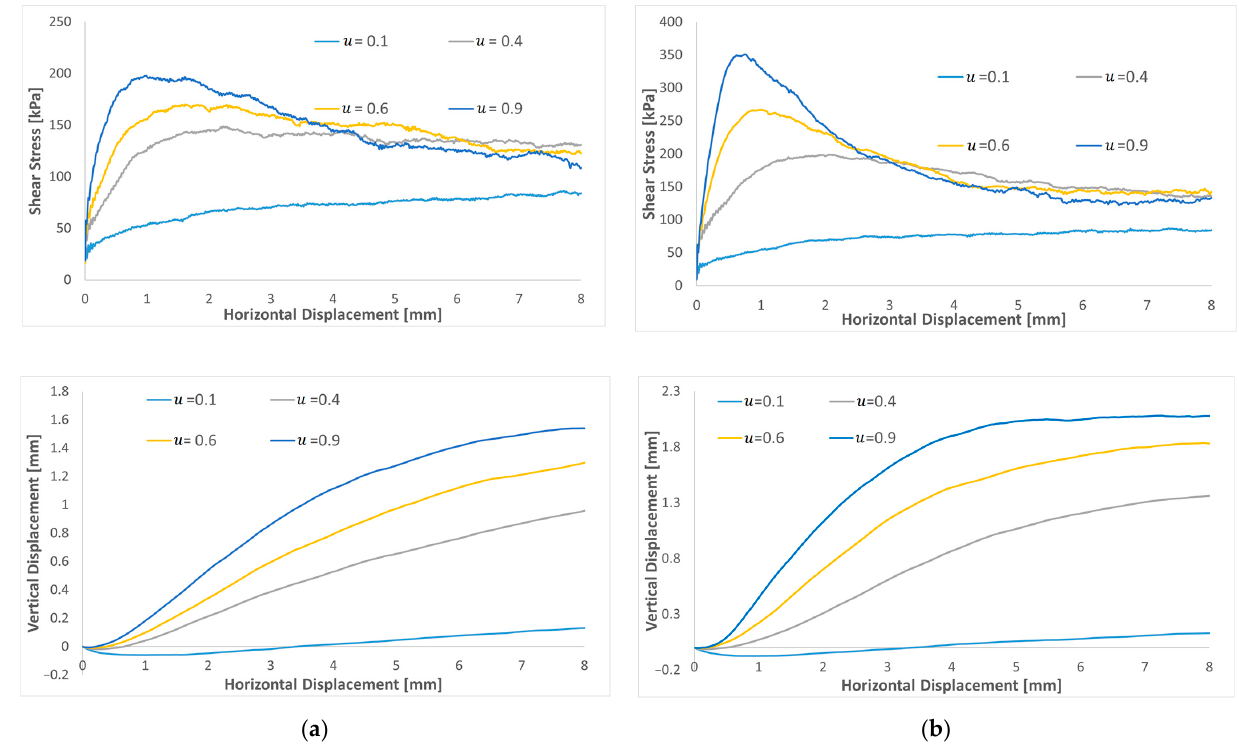
Figure 9. Shear stress and dilatation curves of varying friction coefficient for both high and low rolling resistance friction: ( a ) µ r = 0.2 and ( b ) µ r =